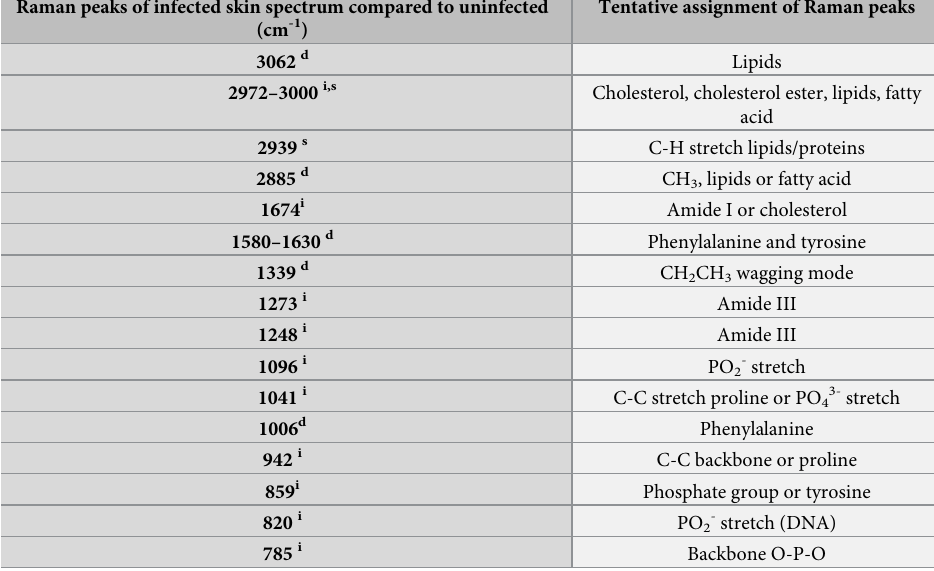
Table 2. Tentative assignment of Raman peaks specific to the trypanosome infected skin, based on Fig 2B and 2C. Specific Raman peak were chosen when they showed a clear shift (s), decrease in intensity (d) or increase of intensity (i) compared to the uninfected skin Raman spectrum. The tentative biological assignment was performed using previ- ously published works from biological tissues. [31,40–42,46]. Raman peaks of infected skin spectrum compared to uninfected (cm -1